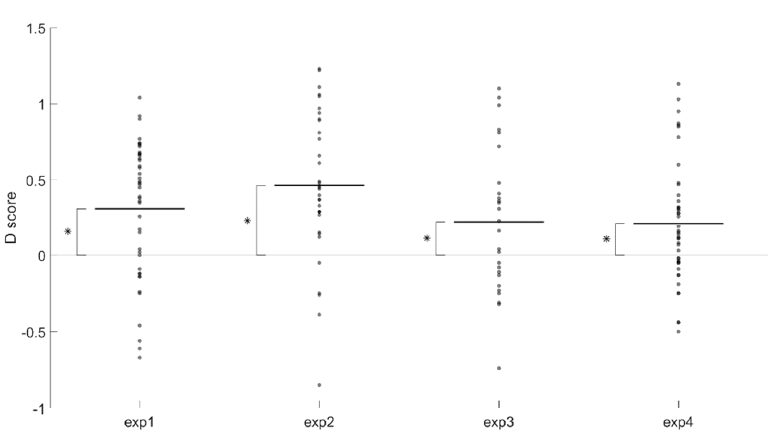
Figure 6. D scores of Experiments 1-4. Each marker indicates the D score for each participant. Short horizontal lines mark the mean D score for each experiment. Positive D scores indicate the presence of the predicted association. Asterisks show the presence of a statistically significant association, as a result of a one sample t ‐ test of the mean D score against zero D score (horizontal line equivalent of no association).